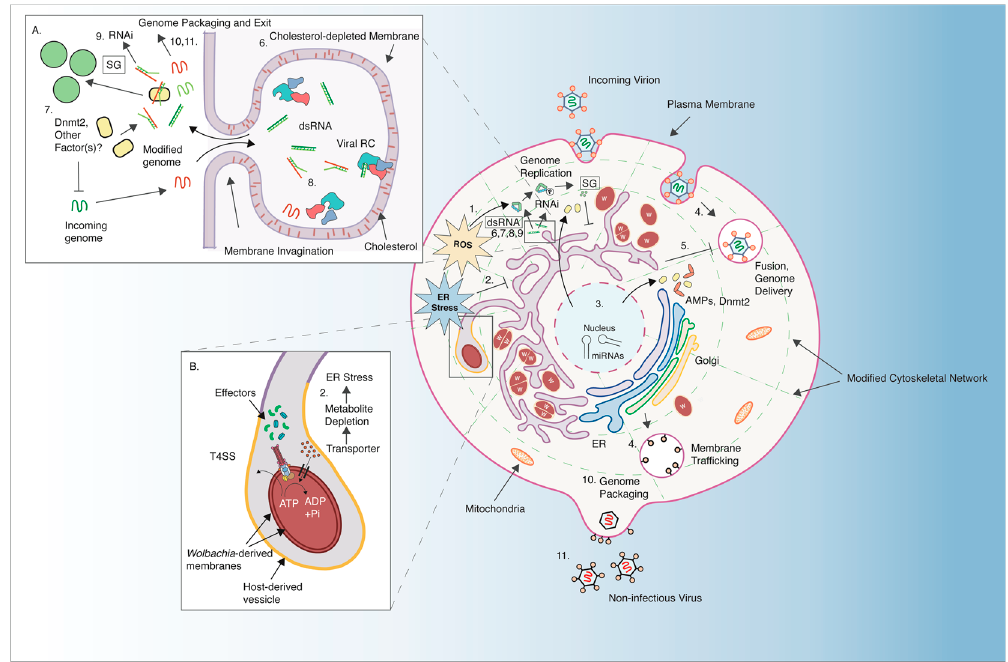
Figure 3. Wolbachia -mediated virus inhibition in arthropods. Wolbachia -mediated virus inhibition is likely a cumulative effect arising from multiple roadblocks at different stages of virus life cycle. 1.